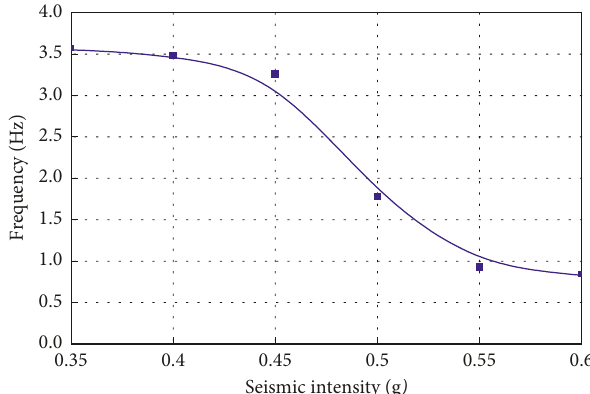
Figure 18: The fundamental frequency of the